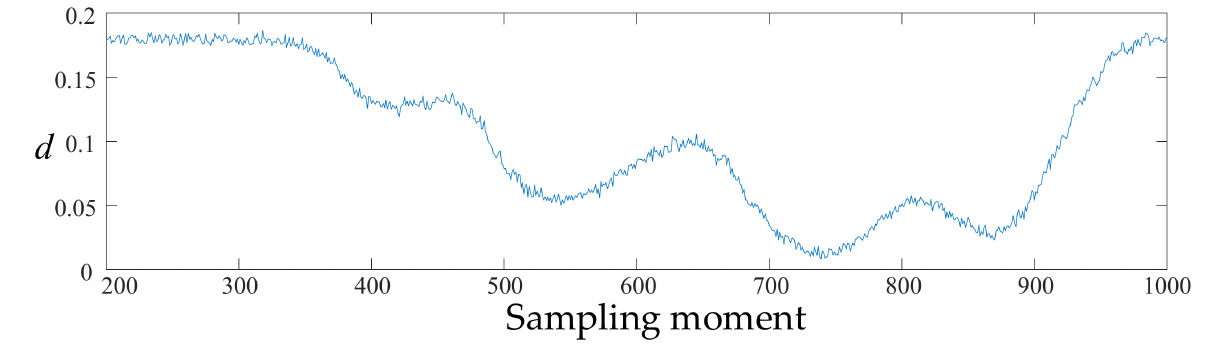
Figure 11. Change curve of d .